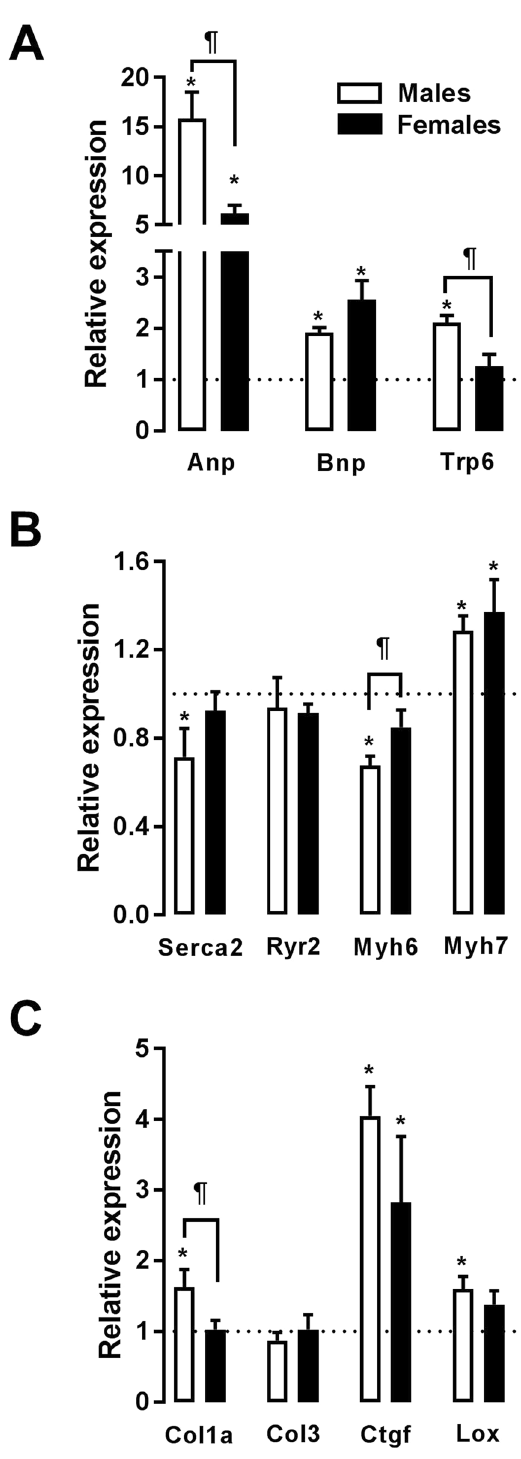
Figure 3. Evaluation by real-time quantitative RT-PCR of the LV mRNA levels of various hypertrophy (top two graphs; A and B ) and extracellular matrix remodelling (bottom; C ) markers. The results are reported in arbitrary units (AU) as the mean ± SEM (n = 5–6/gr.). The mRNA levels of the sham (sham-operated animals) groups (ShM and ShF) were normalized to 1 and are represented by the dotted line. White columns represent the ArM group, and black columns represent the ArF group. * p < 0.05 vs. the corresponding sham group and ¶ p < 0.05 between the ArM and ArF